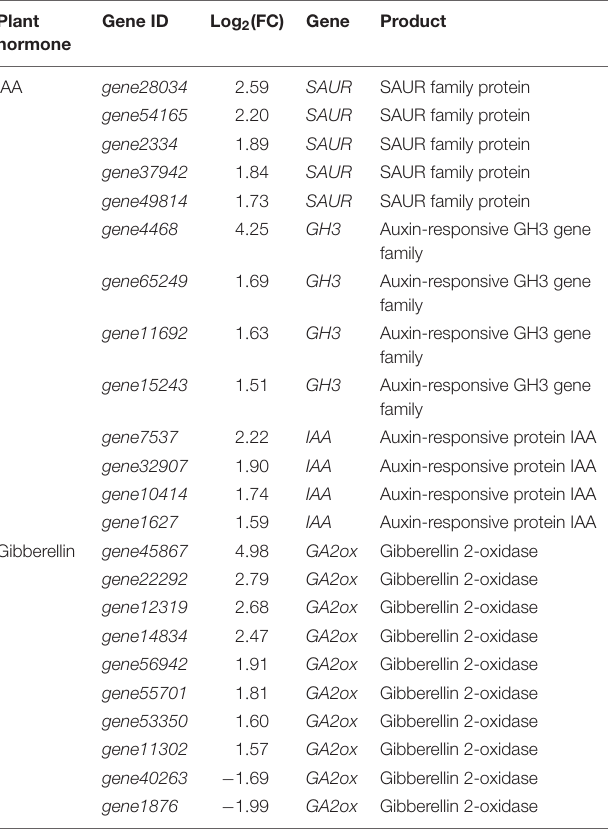
TABLE 2 | Effects of Strain YC0136 on the expression of transcription factors in